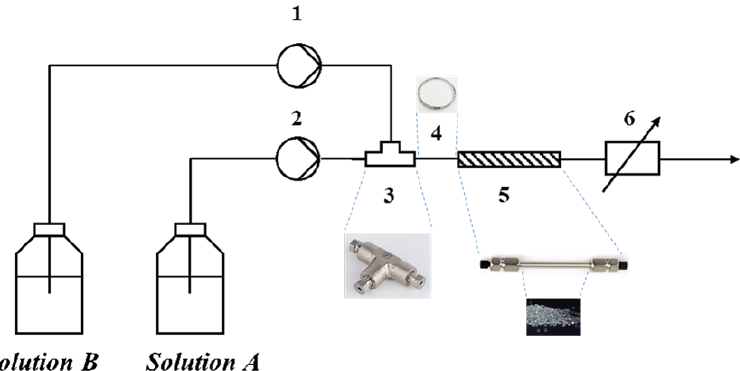
Figure 1. Schematic of the micromixing performance characterization setup: 1 and 2: Delivery pumps; 3: T-type micromixer; 4: Connecting pipe; 5: Micropacked bed reactor; 6: Online UV spec- trometer. Table 1. Concentration of each reactant in the Villermaux/Dushman reaction system.